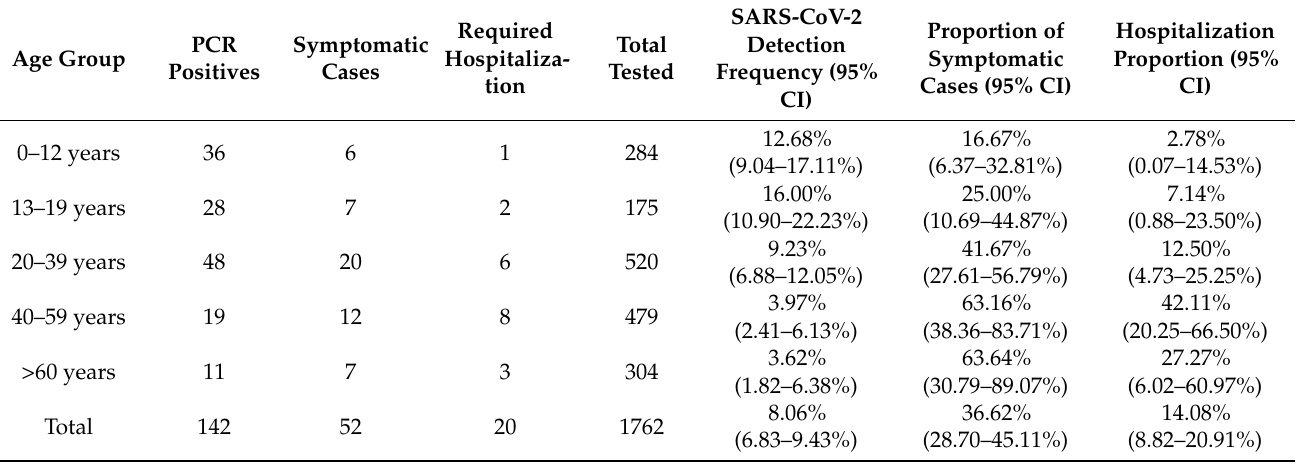
Table 1. Frequency of severe acute respiratory syndrome coronavirus 2 (SARS-CoV-2) detection, proportion of symptomatic cases and hospitalization ratio by age